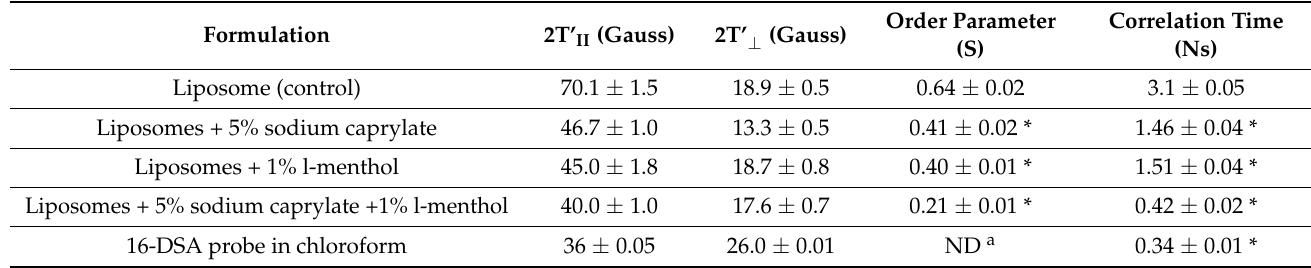
Table 2. ESR parameters of 16-DSA labeled prototype liposomes including permeation